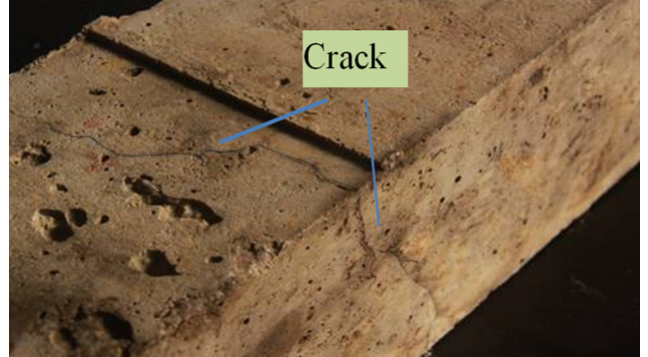
Figure 16 The crack on specimen